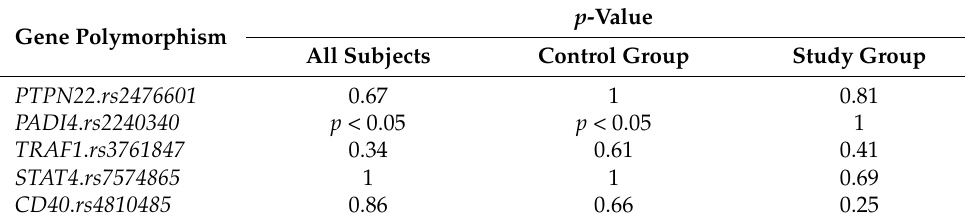
Table 2. The Hardy–Weinberg equilibrium analysis.